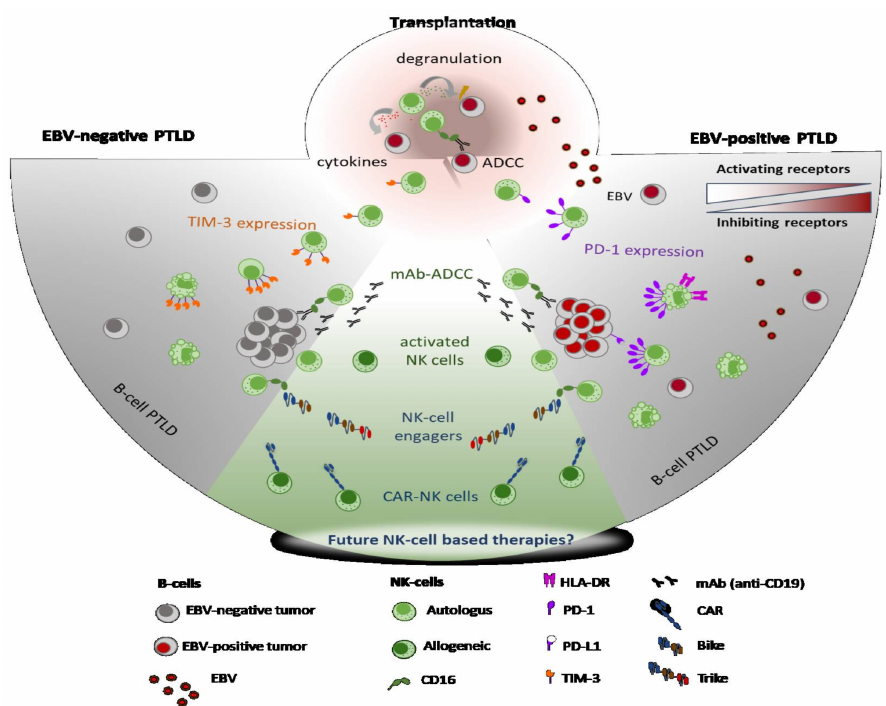
Figure 1. Natural killer (NK) cells are the first lymphocyte compartment to be quantitatively and functionally restored after solid organ or hematopoietic stem-cell transplantation and are the first line of protection against Epstein–Barr virus (EBV)-infected cells and tumor development. At the recognition of EBV-infected or tumor targets, NK cells release perforin and granzymes to mediate the lysis of target cells. Meanwhile, NK cells produce IFN- γ to limit viral infection. Transplant recipients with increasing EBV loads are at high risk of EBV-positive PTLD development and are often treated with rituximab, a monoclonal antibody (mAb) that binds to the CD20 molecule expressed at the surface of B cells. In such cases, NK cells also contribute to the defense of the host by inducing antibody-dependent cell cytotoxicity (ADCC) though the recognition of therapeutic mAbs by CD16. However, solid organ transplantation (SOT) recipients often present increased proportions of NK cells expressing the PD-1 inhibiting immune checkpoint receptor in relation with high EBV loads in blood. During EBV-positive post-transplant lymphoproliferative disorders (PTLDs), NK cells progressively increase PD-1 expression together with the NKG2A inhibiting receptor, while NKG2D and NKp46 activating receptors are downmodulated, a phenotype that might impact NK cell functional capacity against the tumor. In addition to this phenotype, constant NK cell activation has been observed and related to increased activation-induced cell death (AICD), resulting in peripheral NK cell lymphopenia at PTLD diagnosis. In the case of EBV-negative PTLDs, NK cells show increased expression of the Tim-3 inhibiting immune checkpoint receptor, and increased apoptosis has also been associated with mild NK cell lymphopenia at EBV-negative PTLD diagnosis. Besides their central role as cytotoxic innate lymphocytes, NK cells can also be exploited for therapeutic use. Their most frequent role is their cytotoxic activity through ADCC in the context of mAb treatments such as chimeric (rituximab) or humanized (obinutuzmab) anti-CD20 mAbs. Furthermore, autologous infusions of activated NK cells have been used in HSCT recipients with PTLD. Currently, several strategies for NK cell activity enhancement are under development and present characteristics that could allow their utilization in transplanted populations. Bi-specific and tri-specific NK cell engagers, for example, facilitate NK cell synapsing with tumor targets in a very specific manner, and offer the advantage that they can be administered to boost NK cell responses of the host or be coupled with either autologous or allogeneic infusions of NK cells. CAR-NK cells, on the other hand, promise an “off-the-shelf” cellular therapy, so far showing low toxicity and high specificity in immunocompetent